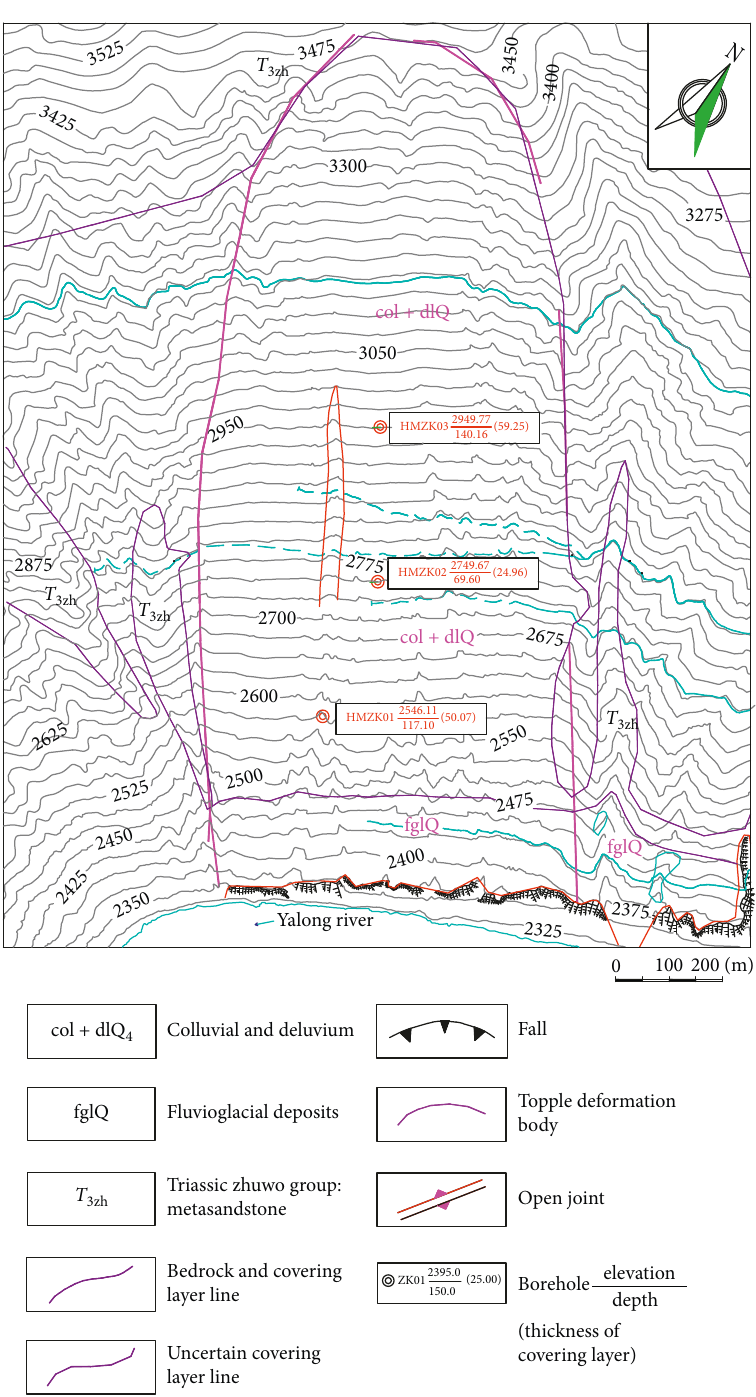
Figure 4: Boundary of Mahe talus